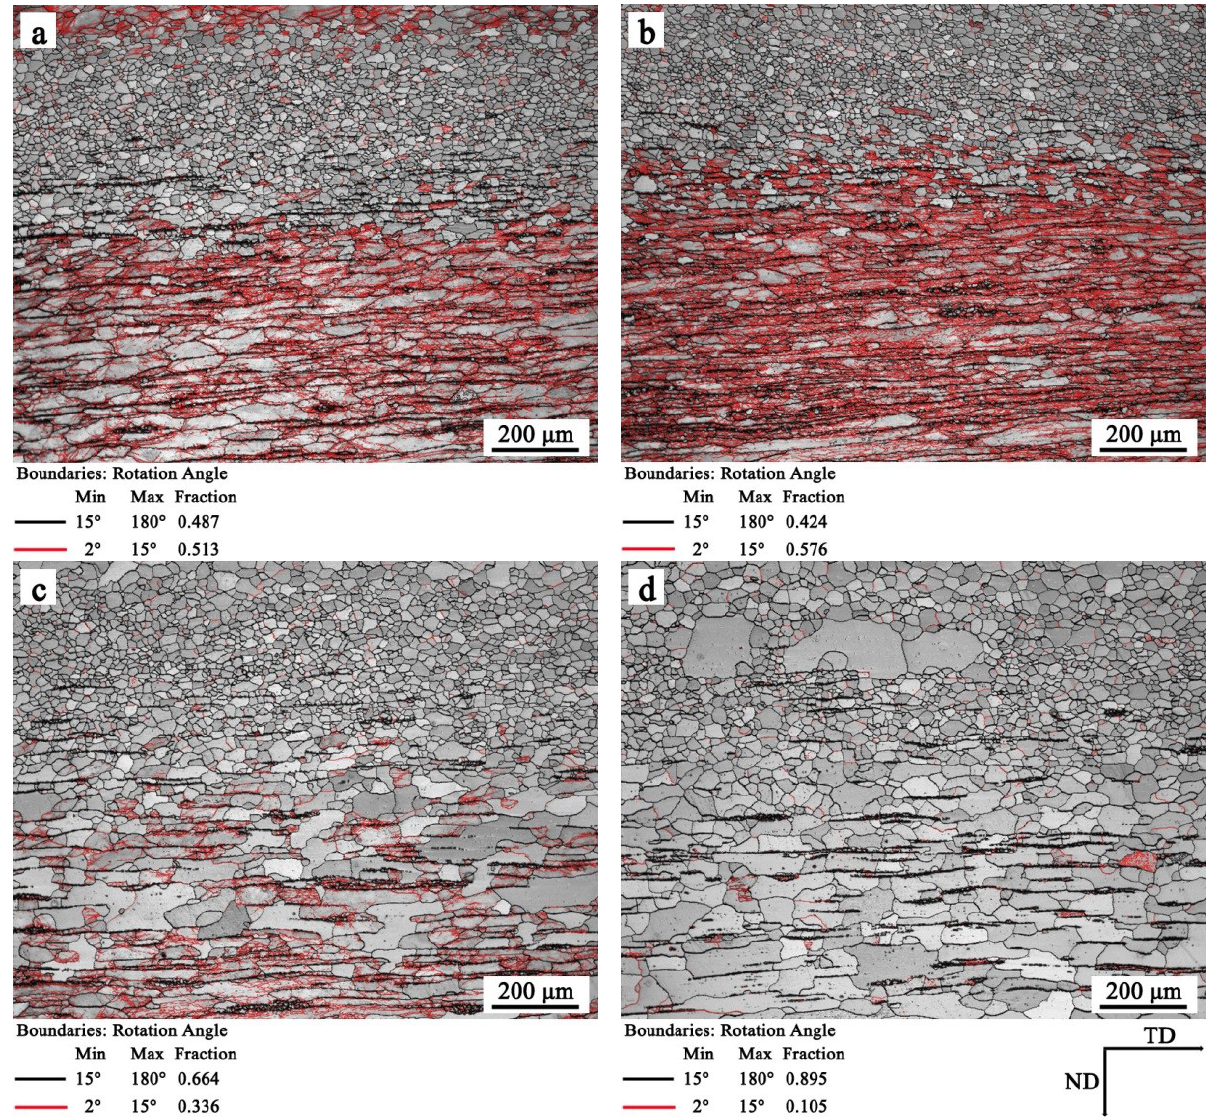
Figure 4: Microstructure of (a) S1-hot rolled, (b) S2-hot rolled, (c) S1-normalized, and (d) S2-normalized